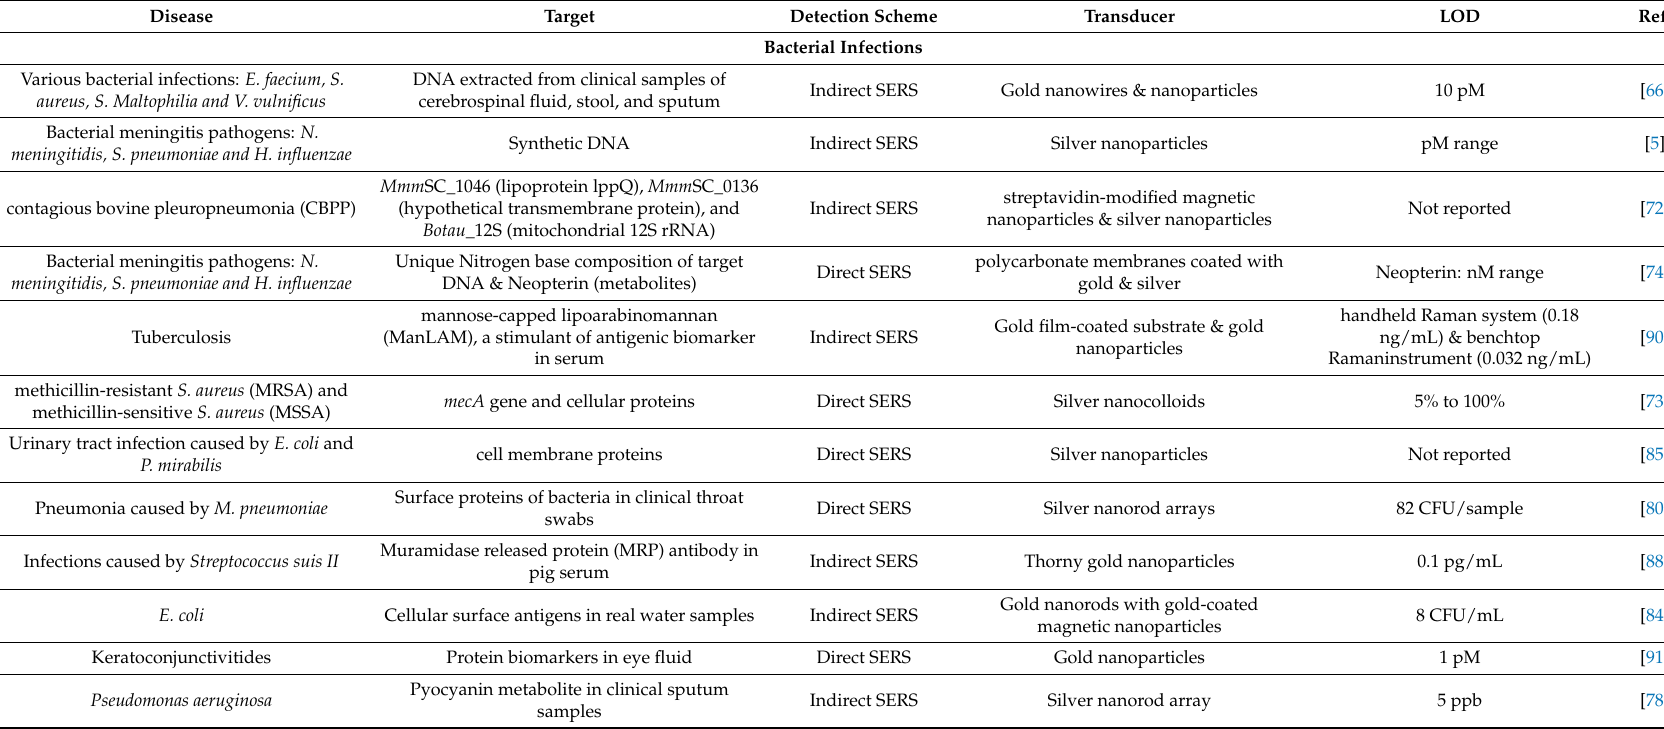
Table 1. Summary of SERS-based biomarker detection methods for bacteria and mosquito-borne infectious